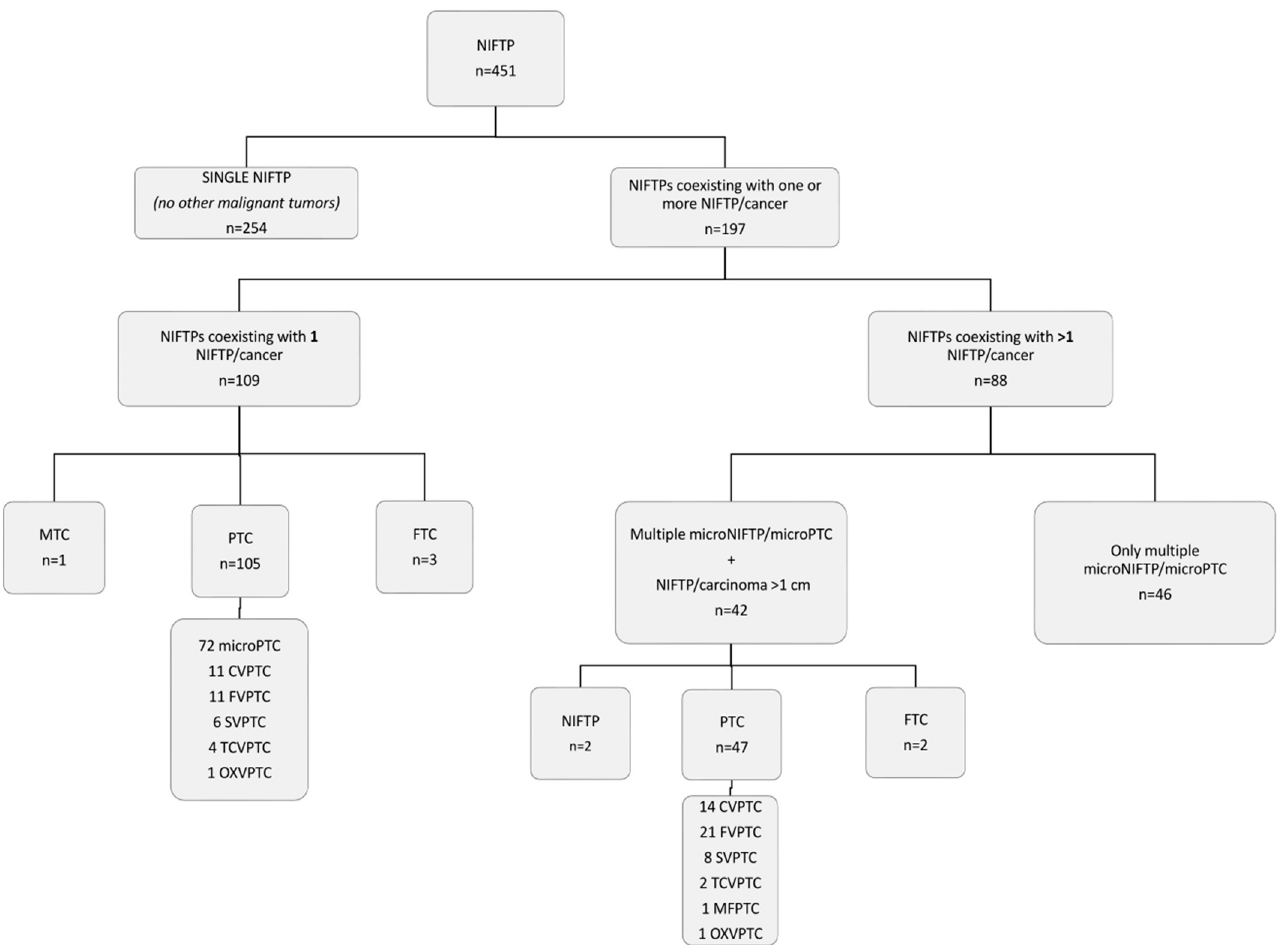
Figure 2. Detailed distribution of the 451 NIFTPs with or without other coexisting thyroid lesions. Abbreviations: NIFTP, non-invasive follicular thyroid neoplasm with papillary-like features, MTC, medullary thyroid carcinoma, PTC, papillary thyroid carcinoma, FTC, follicular thyroid carcinoma,